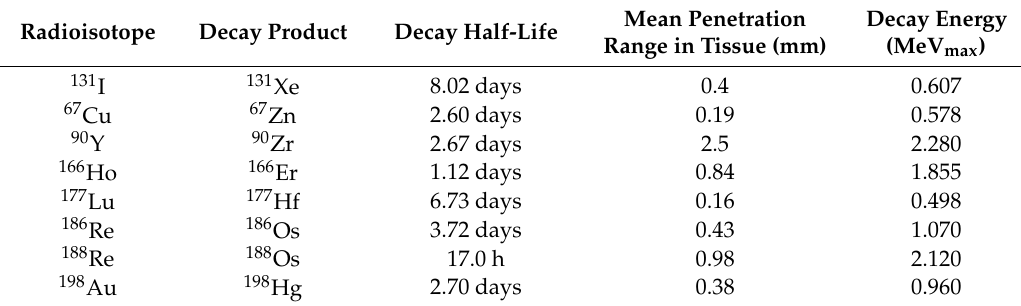
Table 1. Physical properties of β -particles for medical applications Radioisotope Decay